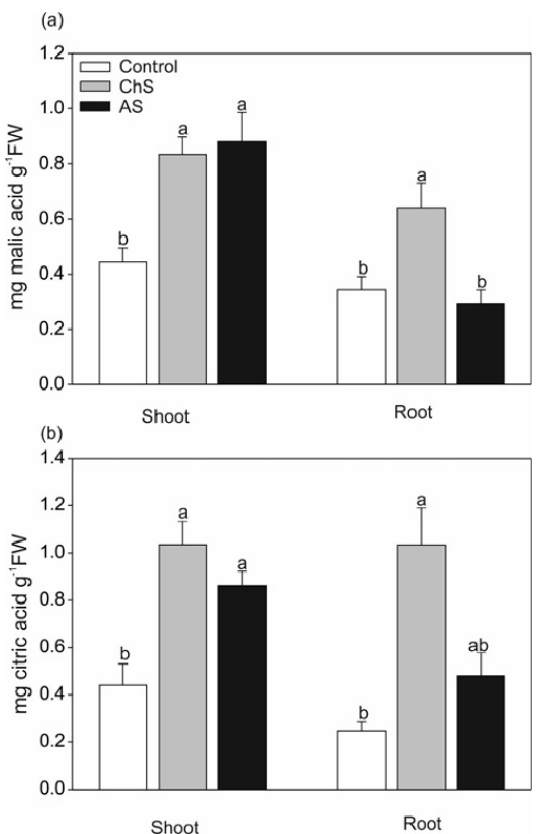
Figure 4. Effect of long-term chronic cadmium stress (ChS, 0.1 µM Cd, 85 days) or short-term acute cadmium stress (AS, 10 µM Cd, 4 days) on ( a ) malic acid; and ( b ) citric acid content in the shoots and roots of C. acaulis . Data are means ± SE ( n = 5); values followed by the same letter are not significantly different ( p < 0.05, Tukey’s test).